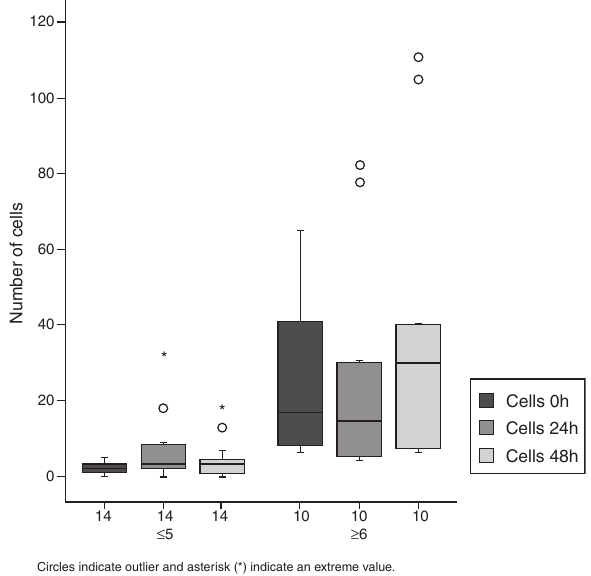
Figure 1 Cellularity in both groups (1 and 2) related to time: 0 h, 24 h, and 48 h.